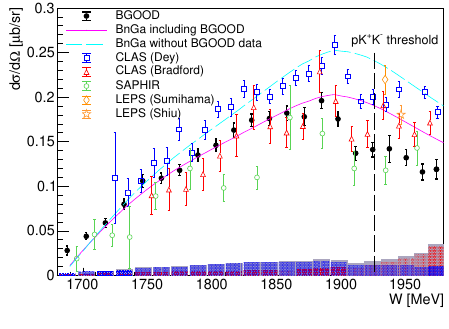
Figure 5. γ p → K + Σ 0 di ff erential cross section, d σ / d t extrapolated to t min versus W ( fi lled black circles). Previous data of other fi nal statesis indicated in the legend. The vertical dashed lines indicate the respective thresholds, with the addition of the K + K − p threshold indicated by the black dashed line. Predictions of K ¯ KN and φ N bound states are shown. Figure and references in Ref.